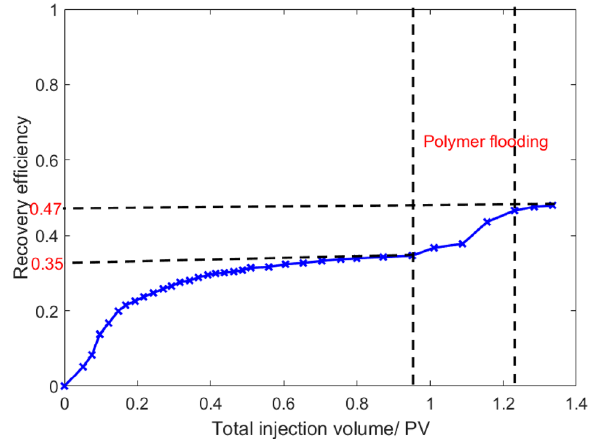
Fig. 5 Relationship between recovery efficiency and injection